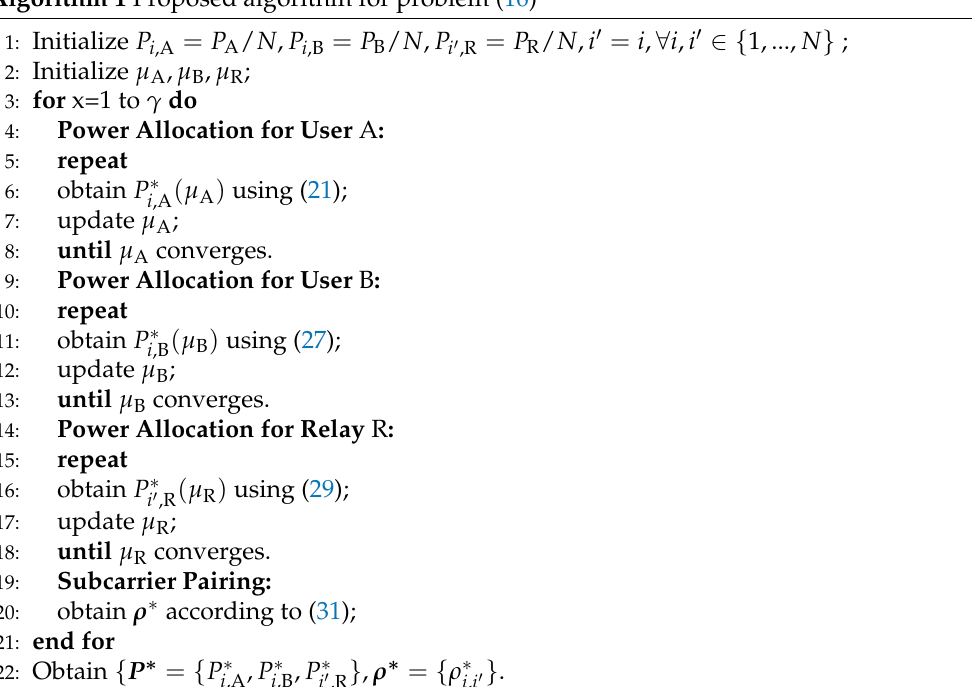
Algorithm 1 Proposed algorithm for problem